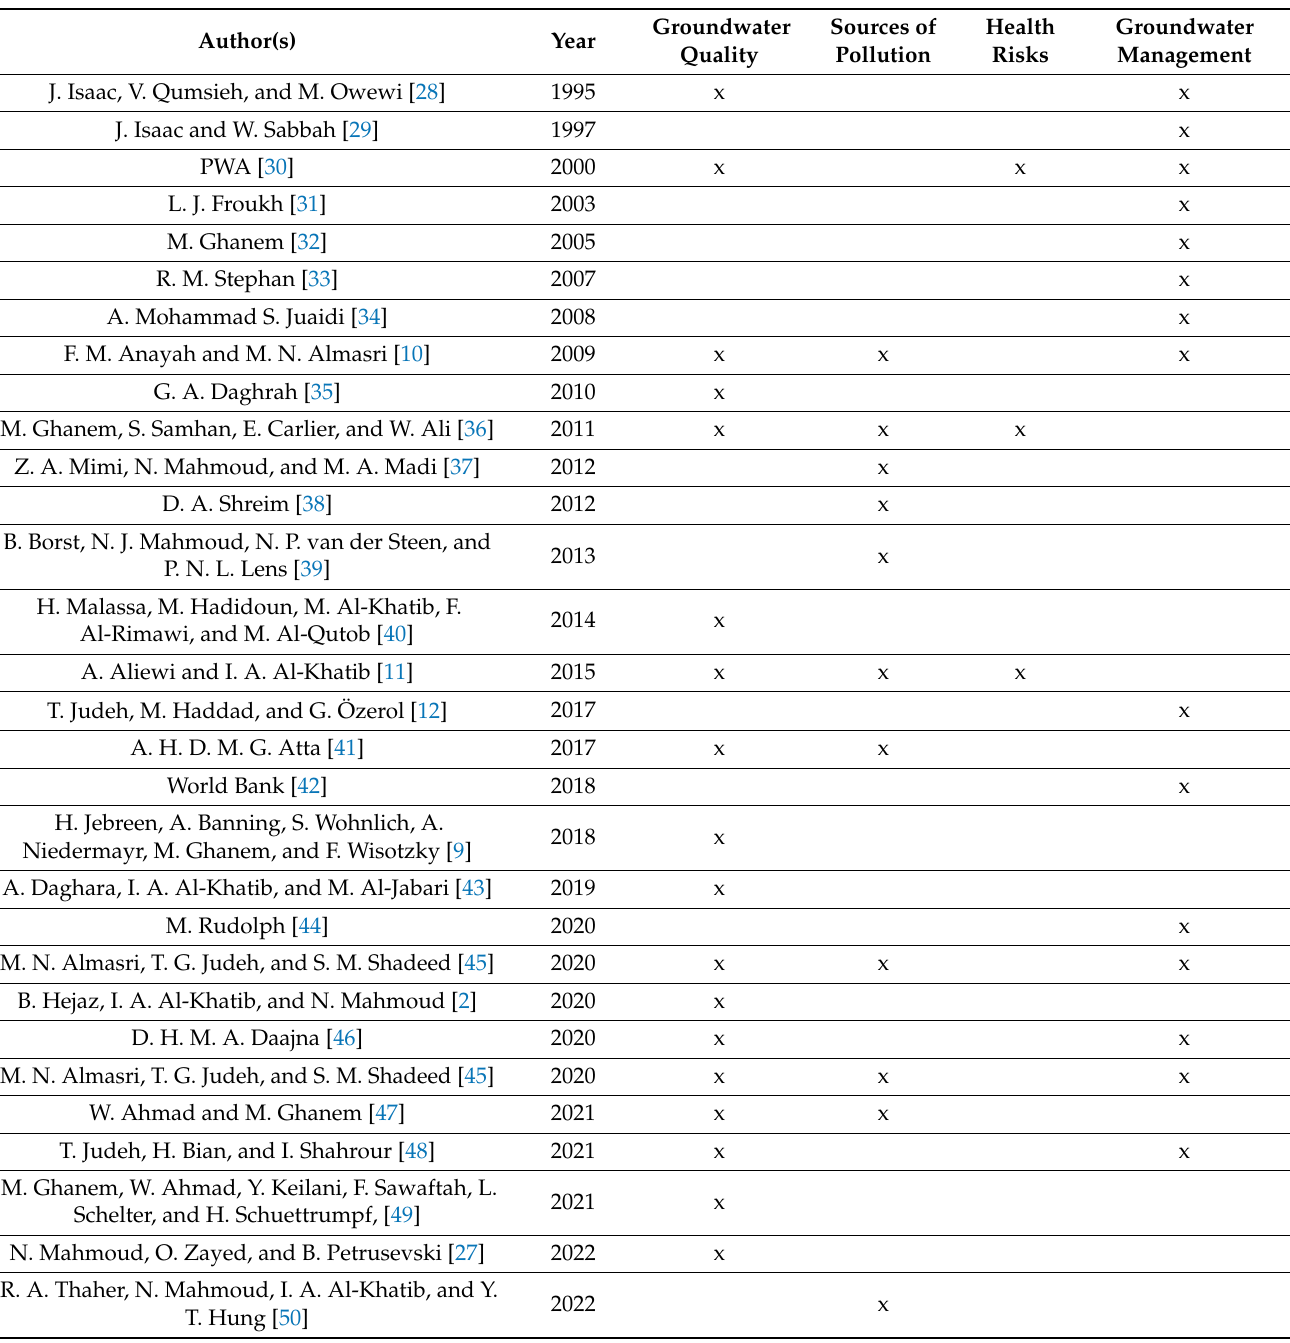
Table 2. Review matrix of groundwater research in West Bank, Palestine, for the years